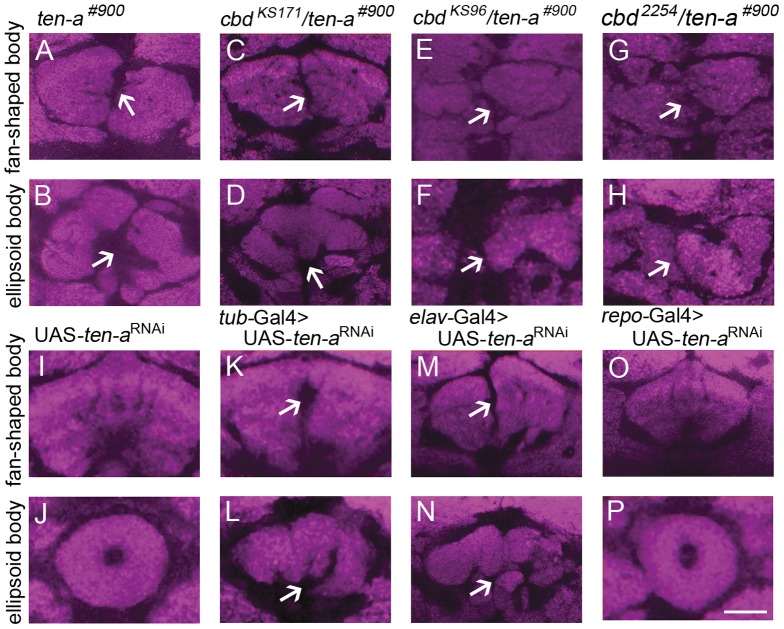

ten-a deficiency line ten-a#900 and down-regulated ten-a expression by RNAi caused FB and EB defects.(A, B) ten-a#900 showed a FB and EB defect. (C–H) cbd KS171, cbd 2254 and cbd KS96 could not complement the FB and EB defect of ten-a#900. (I–L) Both the FB and the EB were destroyed when ten-a was down-regulated by driving expression of UAS-ten-a
RNAi with tub-Gal4. (M–N) Both the FB and the EB were destroyed when ten-a was down-regulated by driving expression of UAS-ten-a
RNAi with pan-neuronal elav-Gal4. (O–P) Both the FB and the EB were normal when ten-a was down-regulated by driving expression of UAS-ten-a
RNAi with pan-glial repo-Gal4. Scale bar, 25 µm. Arrows indicate the central complex defect.